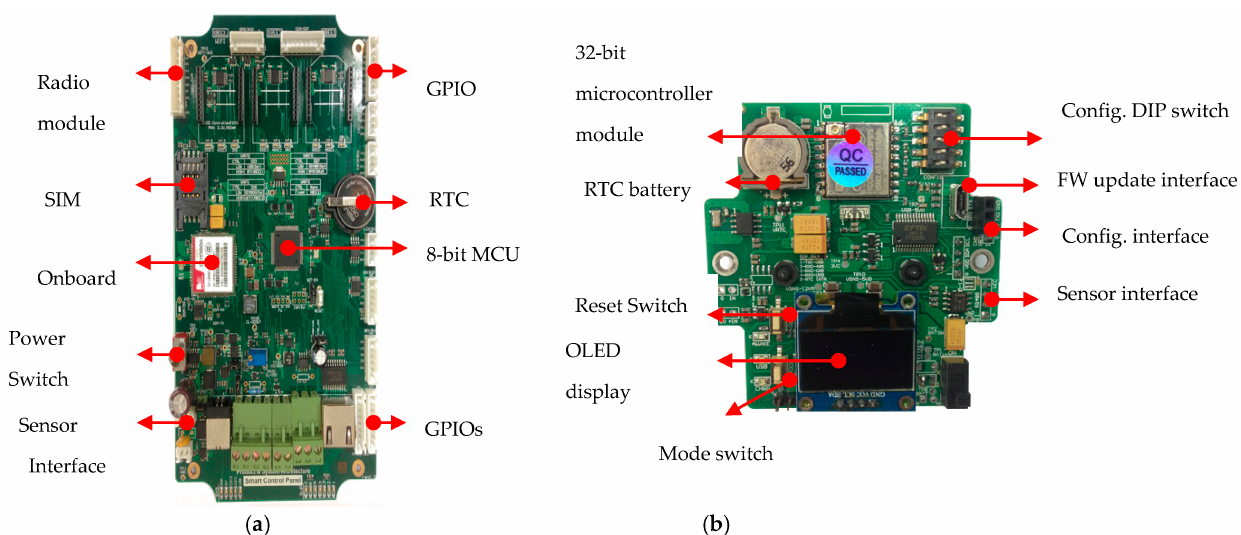
Figure 1. System architecture.